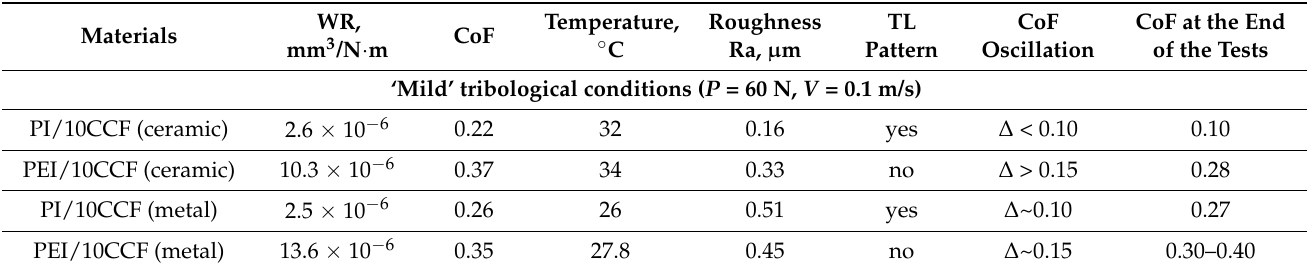
Table 6. A comparison of the tribological properties and the TL characters for the PI/10CCF